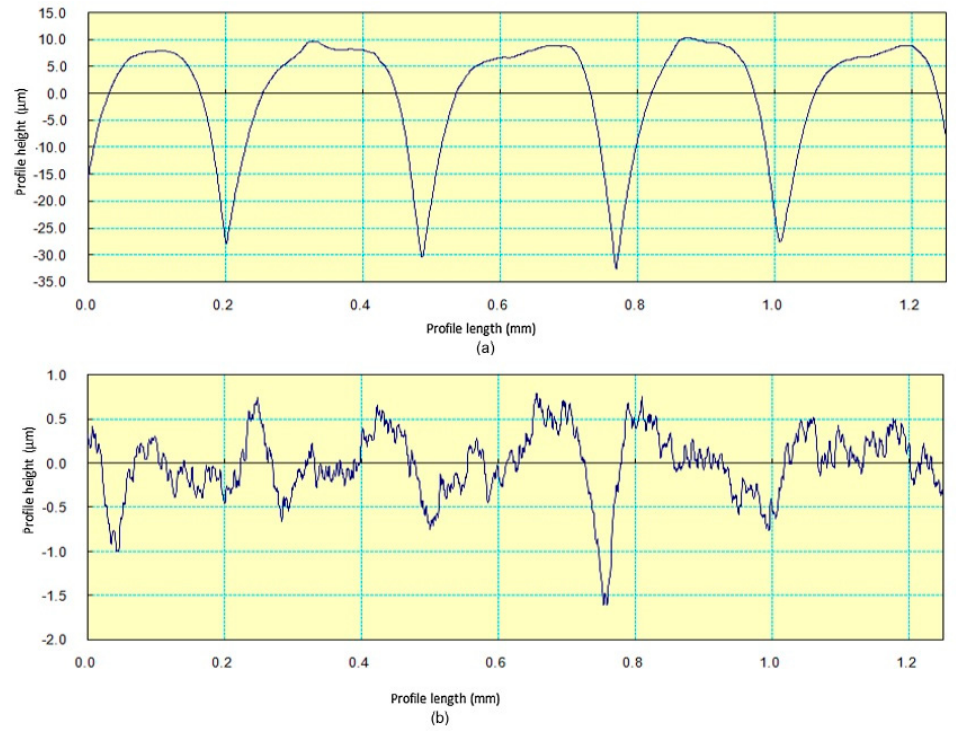
Figure 6. Surface Roughness Profiles of Specimen ( a ) before finishing ( b ) after finishing.